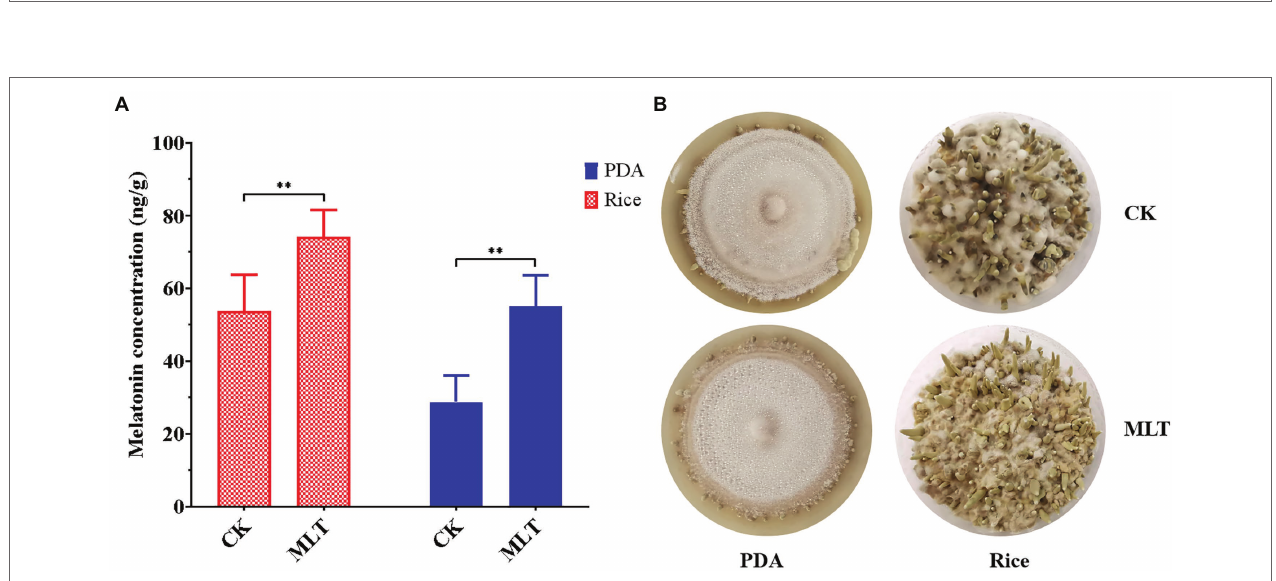
FIGURE 5 | Effect of exogenous melatonin on the mycelial growth of T. guangdongense under CR (A) , H2O2 (B) , CT (C) and HT stress (D) , respectively. CT, cold stress; CR, cango red; HT, heat stress; MLT, melatonin; Lowercase letters represent significant difference ( p < 0.05).